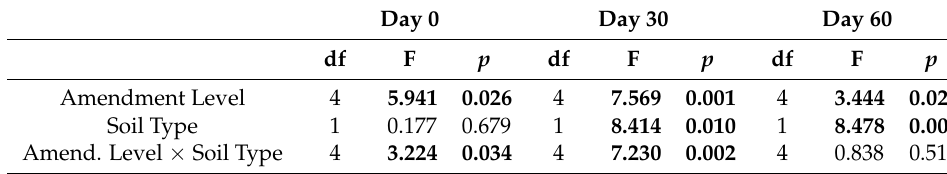
Table 4. Results from ANOVA (degrees of freedom, df; F-values, F; and probabilities, p ) for potential nitrification for each measurement period. Day 0 represents the first measurement day following a one-week pre-incubation period. Significant F and p values are given in